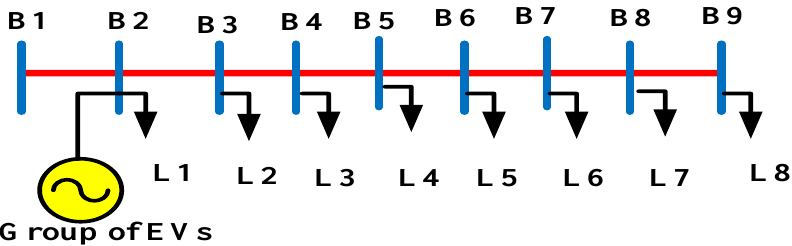
Figure 4. Single-line diagram of the radial distribution system at the time of restoration.